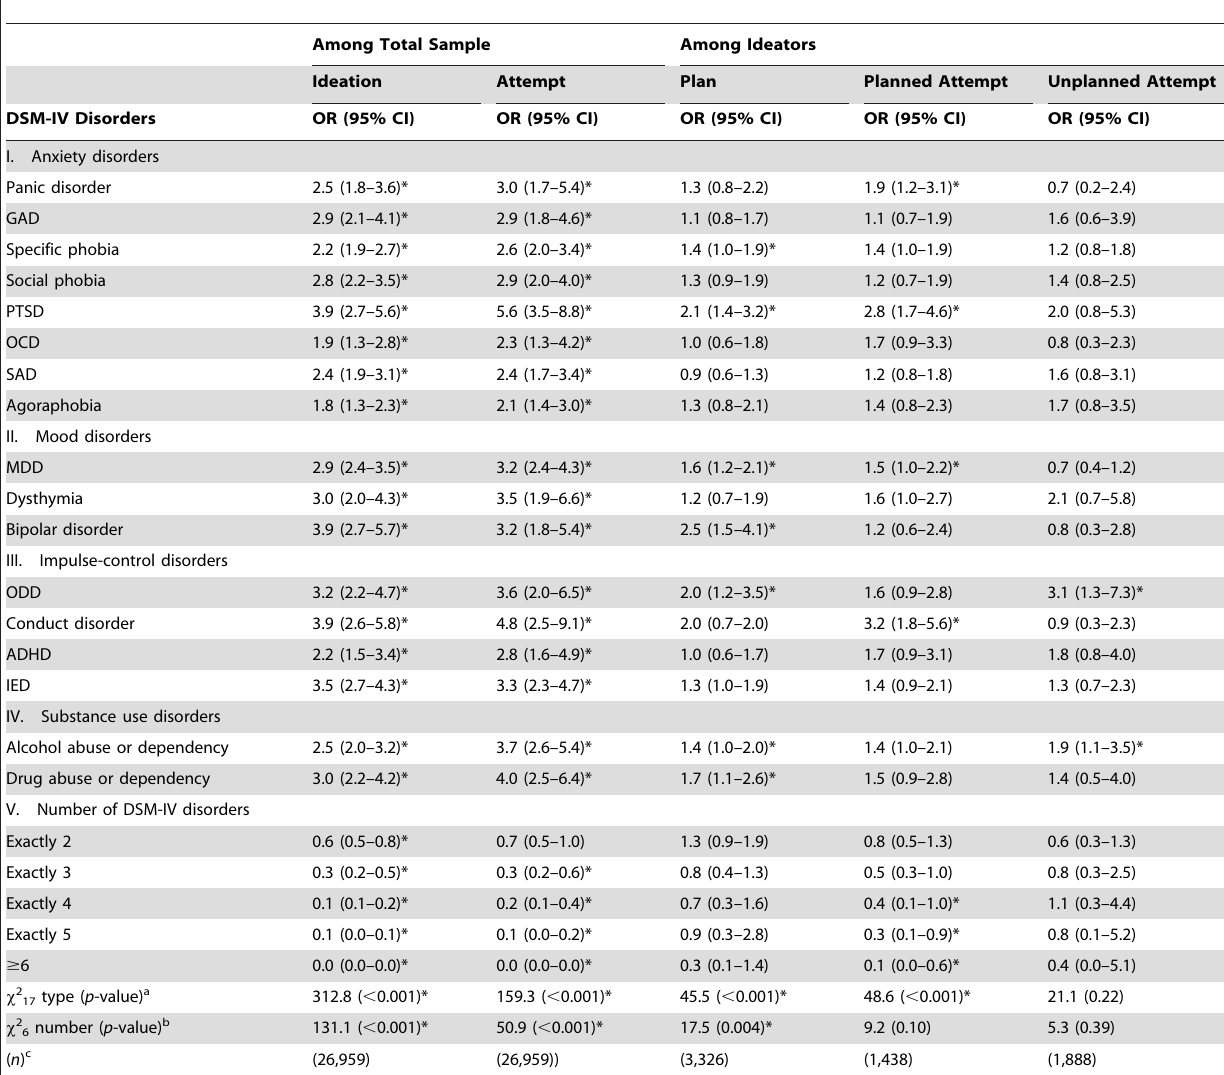
Table 7. Multivariate survival models of associations between type/number of prior DSM-IV disorders and subsequent suicidal behavior—developing